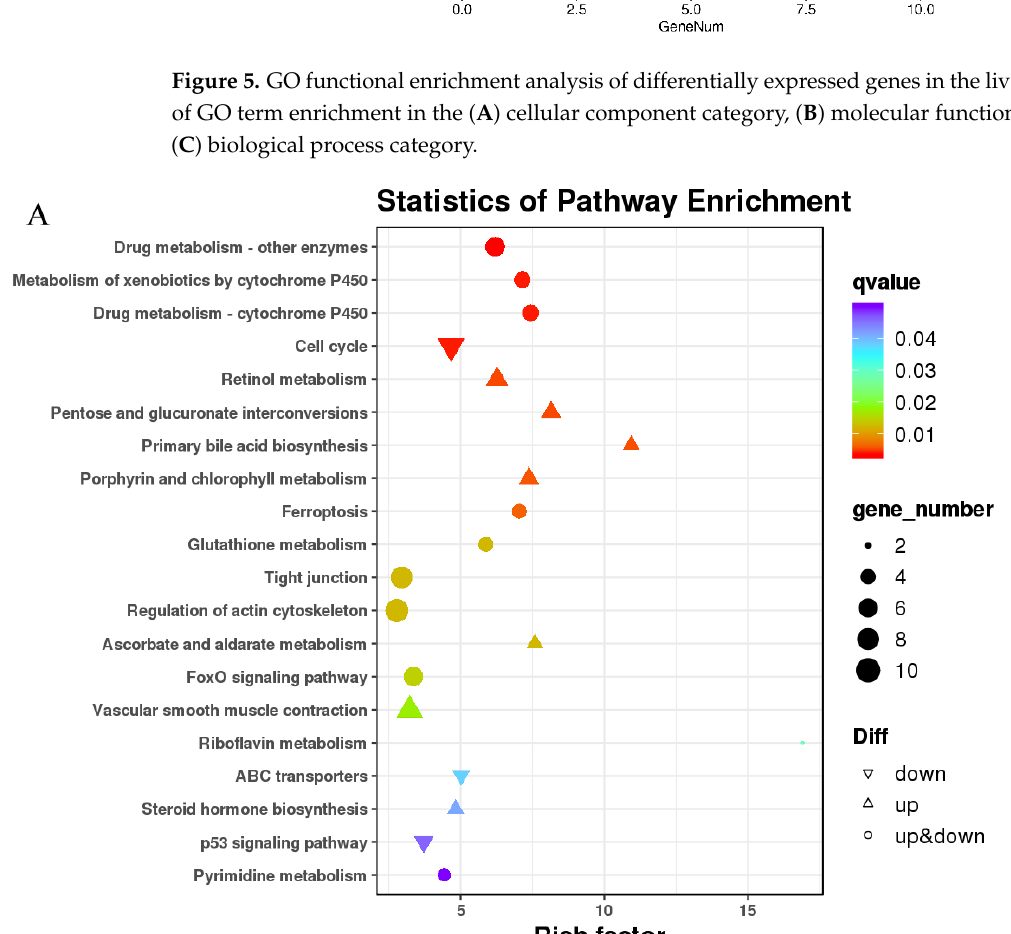
Figure 6. KEGG enrichment and classification. ( A ) Scatter plot of KEGG pathway enrichment results for differentially expressed genes: the ordinate represents the pathway name, the abscissa repre- sents the enrichment factor, and the color represents the q-value (i.e., the p -value after correction for multiple hypothesis testing). The size of the circle indicates the number of genes involved in the pathway. ( B ) KEGG classification diagram: the left-hand vertical axis shows the KEGG pathway name, and the right-hand vertical axis shows the category corresponding to each pathway. A shared column color indicates the same category.